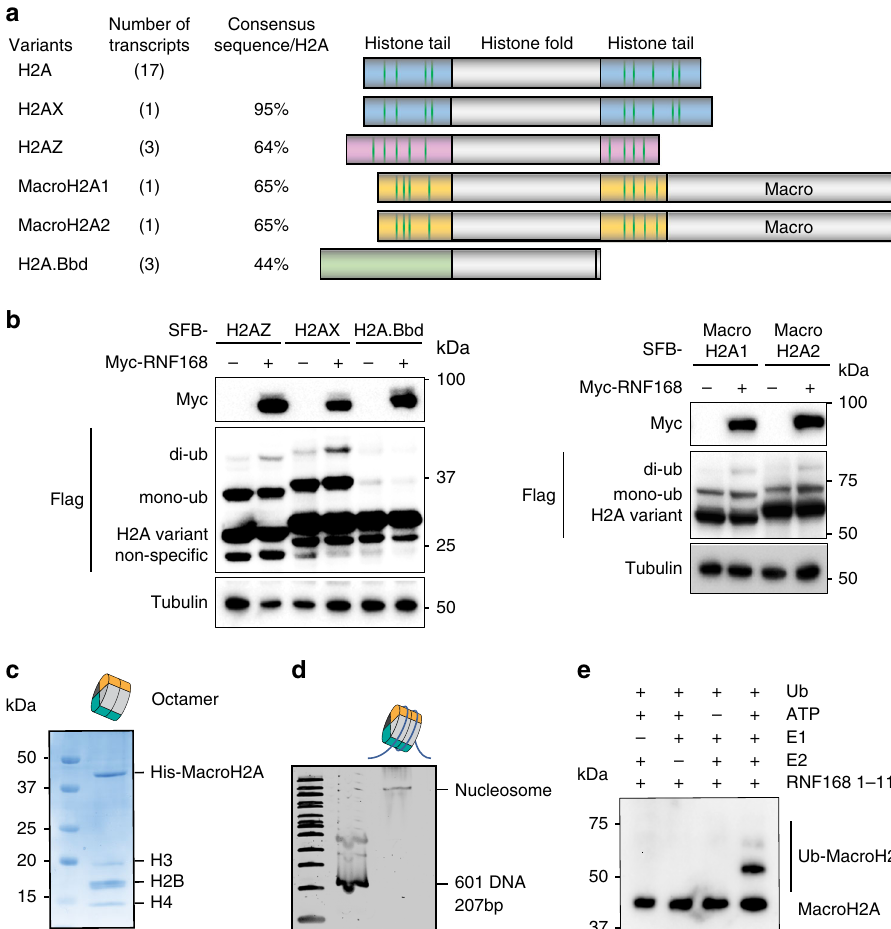
Fig. 1 H2AZ and macroH2A1/2 are RNF168 substrates. a Schematic illustration of the human H2A family. Consensus sequences were analyzed in comparison to H2A. For macroH2A1 and macroH2A2, the macro domain is excluded from the sequence homology analyses. Green lines represent lysine residues in the histone tail regions. b RNF168 ubiquitinates H2A variants. Cells were co-transfected with Myc-RNF168 and SFB-H2A variants in HEK293T cells, then harvested in SDS-PAGE sample buffer followed by western blot analysis with indicated antibodies. H2AX was used as a positive control. Repeated three times independently with similar results. c Coomassie staining of macroH2A-containing octamer. d Analysis of in vitro reconstitution of macroH2A-containing nucleosome core particles (NCPs). The 207bp 601 DNA fragment was analyzed alone or after NCP reconstitution. 100 bp DNA ladder indicates size. e in vitro ubiquitination assay of macroH2A-conatining nucleosome was incubated with E1, E2, RNF168 (1-113), ATP and ubiquitin in 1× ubiquitination buffer at 30 o C overnight. The reactions were stopped by adding 2× SDS sample buffer. Samples were analyzed by western blot and macroH2A antibody. Repeated three times independently with similar results. Source data are provided as Source Data fi